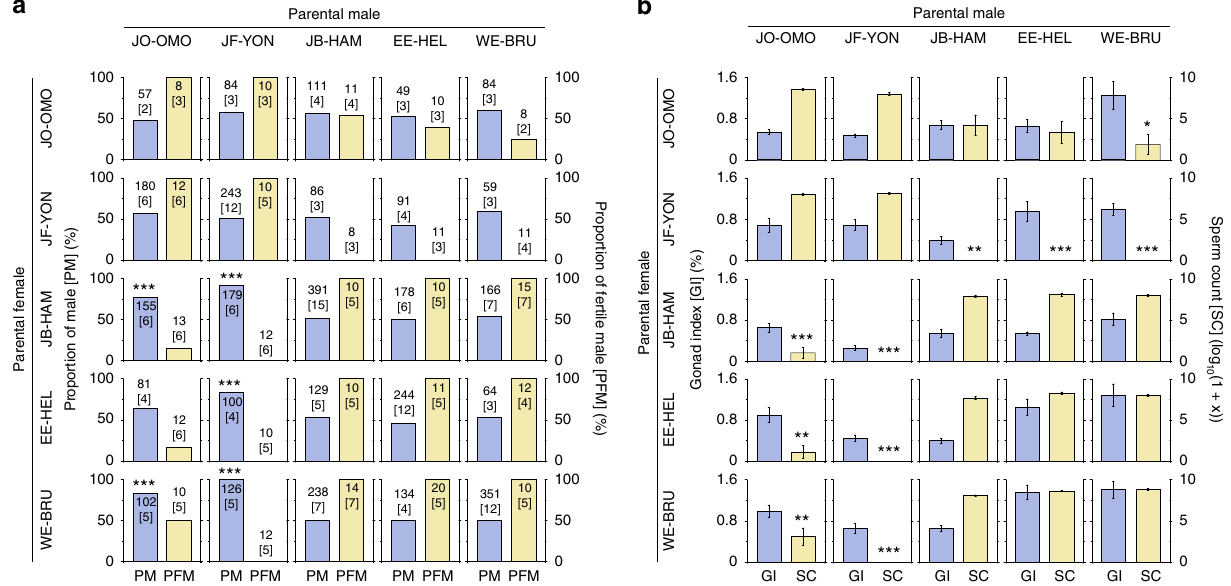
Fig. 4 Hybrid incompatibility in interlineage crosses. a The proportions of adult males and of fertile males in fi ve lineages and their crosses. Sterile and fertile males are identi fi ed based on the absence and presence of sperm in the testes, respectively. Sample numbers are shown in the graphs with family numbers in brackets. Signi fi cant deviations from a 1:1 sex ratio are indicated with asterisks (*** P < 0.001). b Gonad index, as a measure of testis size, and sperm count in males in the same cross combinations as in a . Means and standard errors are shown. The data are based on the same individuals used for the analyses of sterility and fertility in a . Hybrids with signi fi cant differences from both parental populations are indicated with asterisks (* P < 0.05, ** P < 0.01, and *** P <